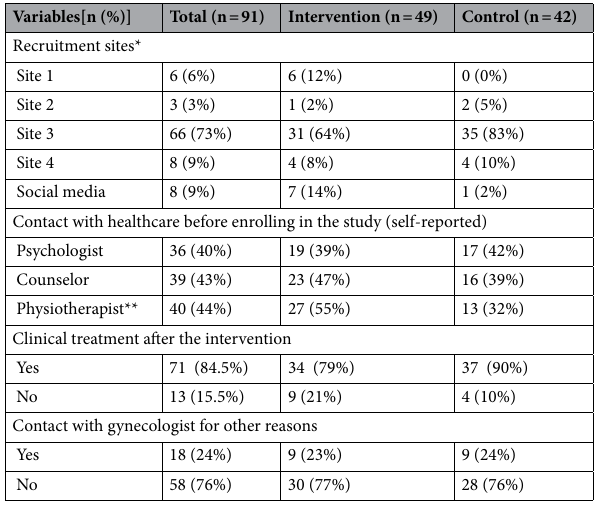
Table 1. Participant characteristics. * p = 0.04 for differences between groups regarding recruitment sites (Mann Whitney’s test). ** p = 0.02 for difference between groups regarding previous contact with a physiotherapist (chi-square test).